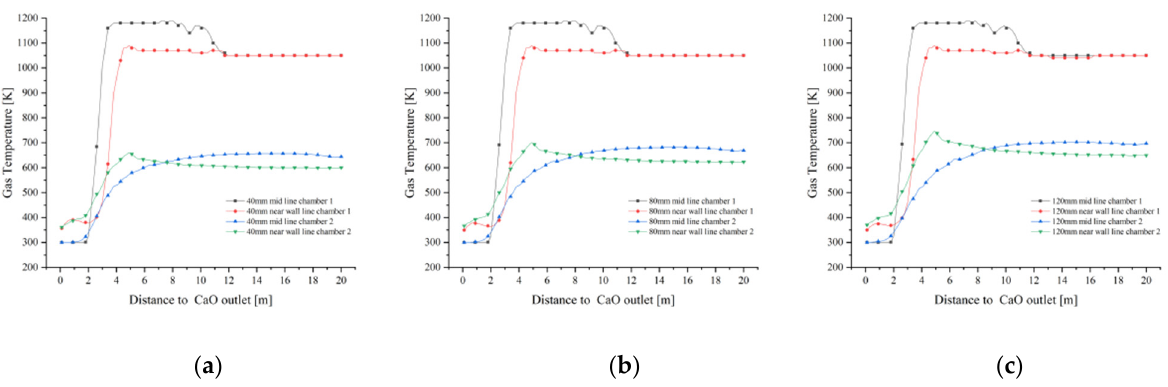
Figure 7. Gas temperature variation on the mid and near wall lines for 40 mm, 80 mm and 120 mm particle sizes. ( a ) Gas temperature variation at 40 mm ( b ) Gas temperature variation at 80 mm ( c ) Gas temperature variation at 120 mm.